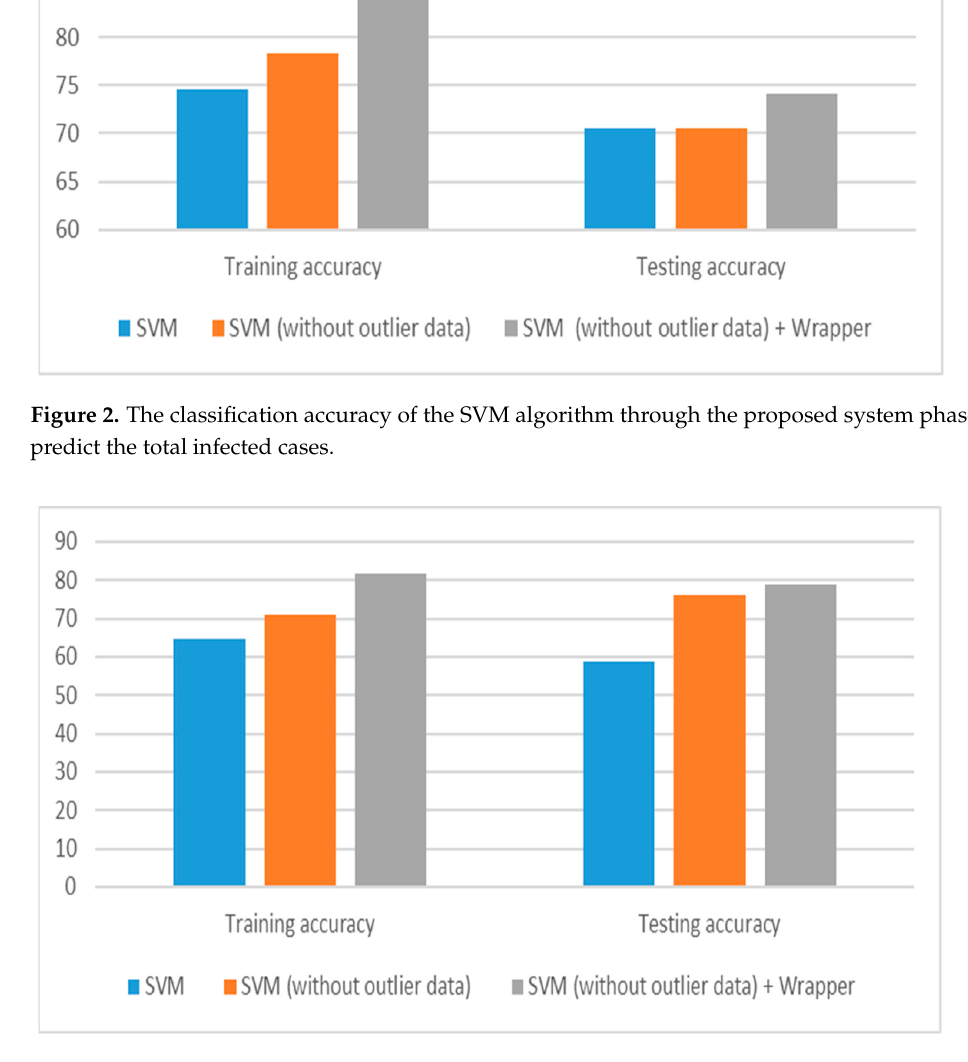
Figure 4. The classification accuracy of the SVM algorithm through the proposed system phases to predict the total critical cases.